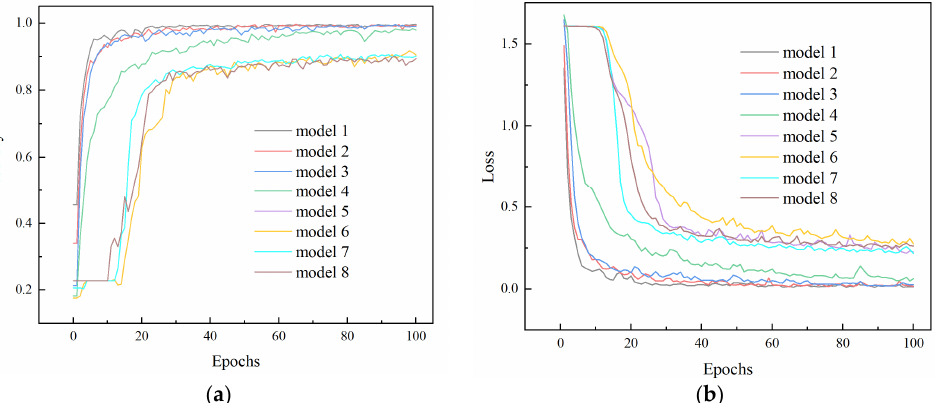
Figure 9. Network structure of Models 5–8.